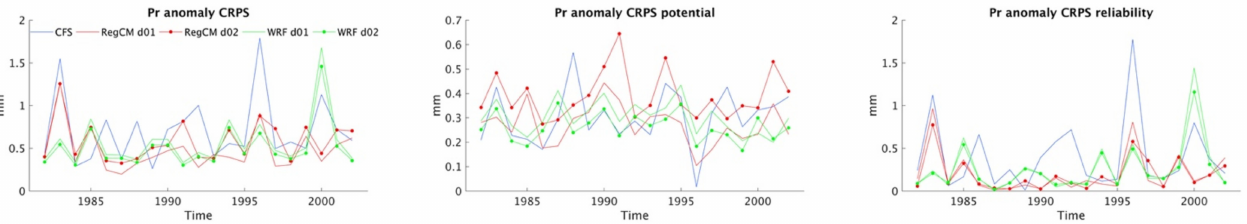
Figure 8. Same as Figure 7 but for the